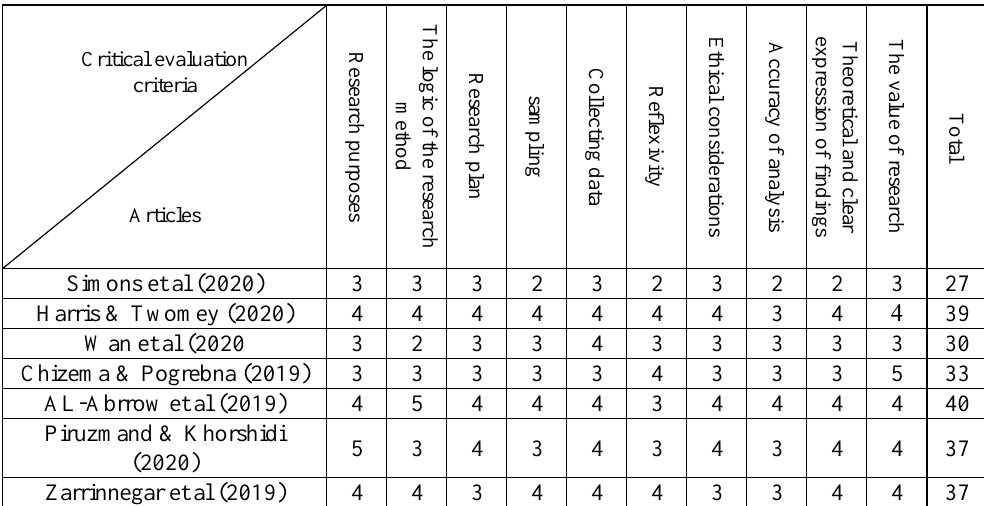
Table 5. the process of critical analysis of screened research